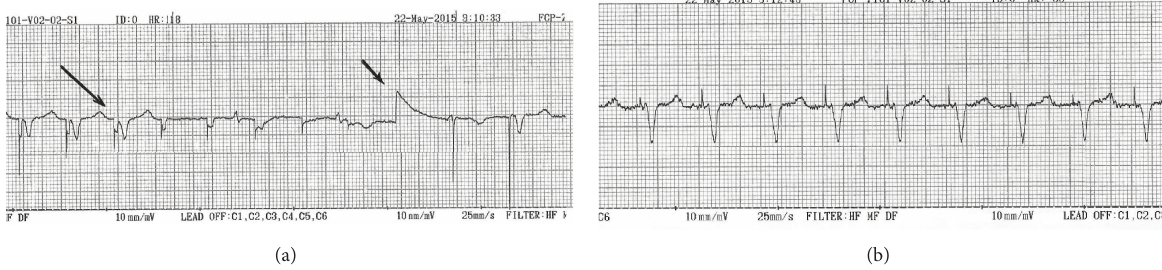
Figure 1: (a) “Vario” method for pacing threshold evaluation with automatically decreased consecutive steps of pacing voltage output. Spike deflection (small arrow) presents zero voltage. Backwards from that zero point, each spike presents increased voltage with steps of 0.15 V. The 5 spikes at the left of zero point with no capture represent steps of 0.15–0.75 V. Capture is succeeded by the 6th spike before zero point (large arrow), with output 0.9 V/0.5 ms (pacing threshold on May 22, 2015). (b) Magnet rate of 99bpm on May 22, 2015 (recommended replacing magnet rate ≤ 85 bpm).